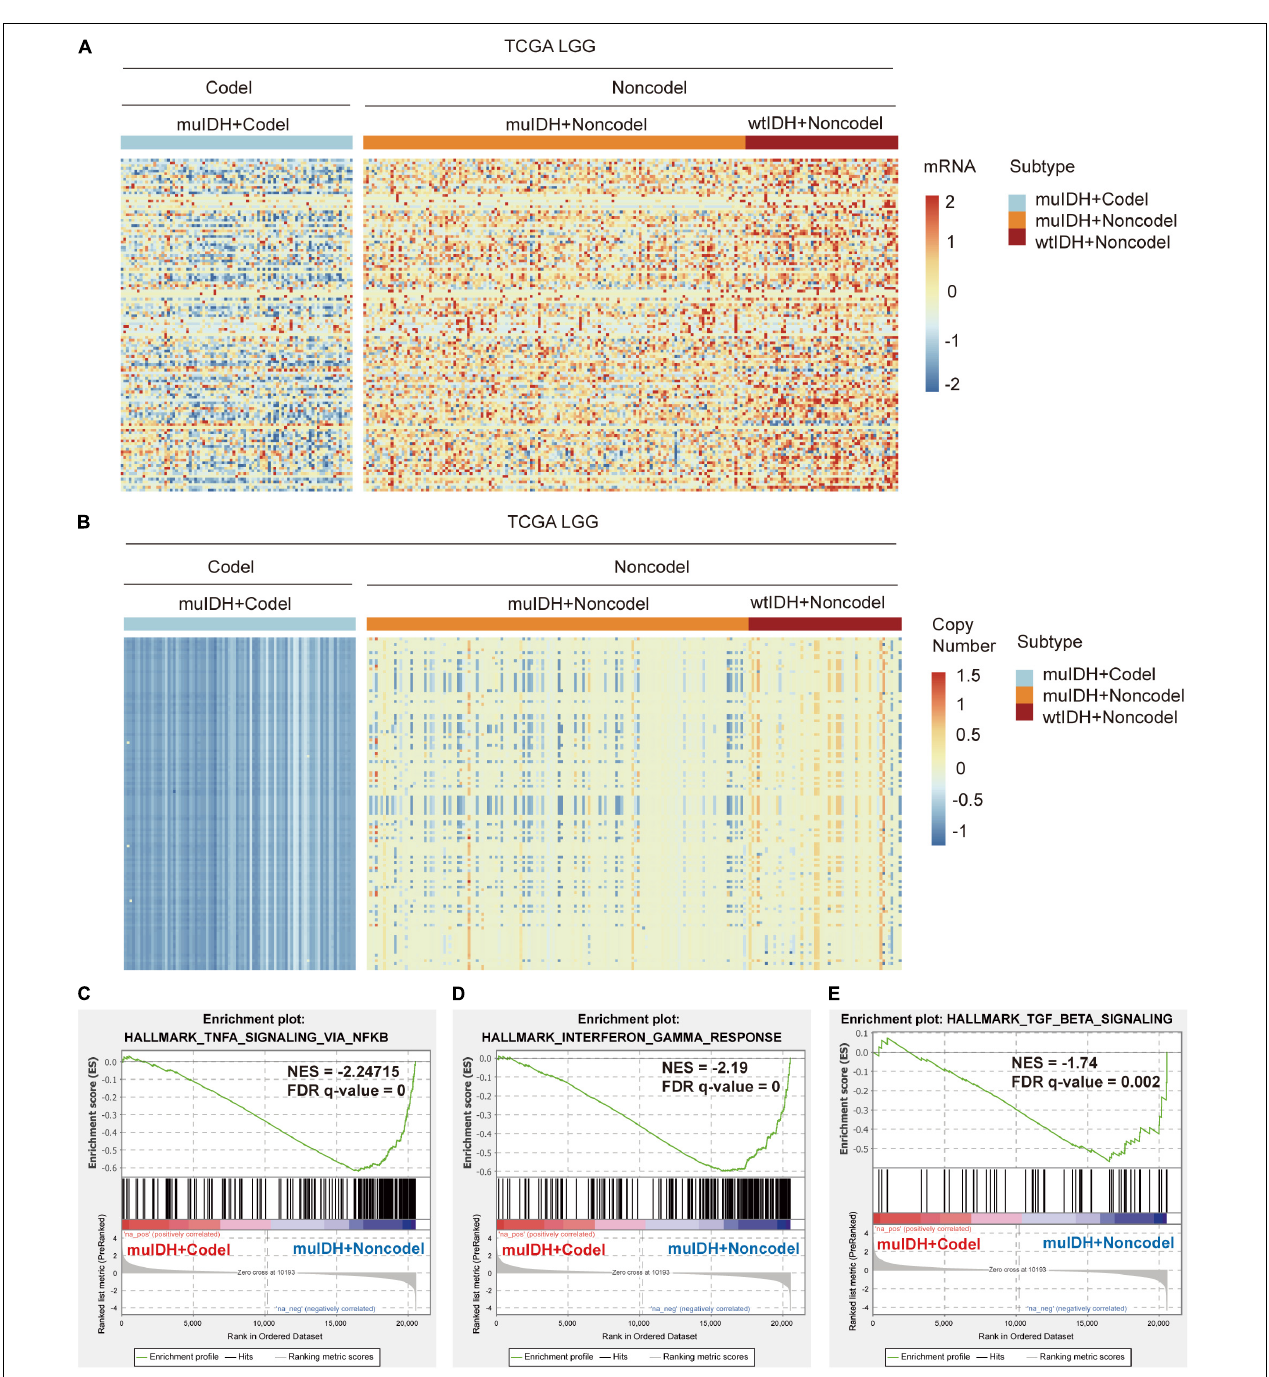
FIGURE 8 | Expression and copy number variation of immune-related genes on chromosome 1p/19q. (A) Heatmap of differentially expressed immune-related genes in LGG patients among different subgroups in TCGA LGG. (B) Heatmap of copy number variation of immune-related genes in LGG patients among different subgroups in TCGA LGG. (C–E) Gene set enrichment analysis indicates a significantly reduced “TNFA SIGNALING VIA NFKB” (C) , “INTERFERON GAMMA RESPONSE” (D) , and “TGF BETA SIGNALING” (E) in the cases of LGGs with 1p/19q